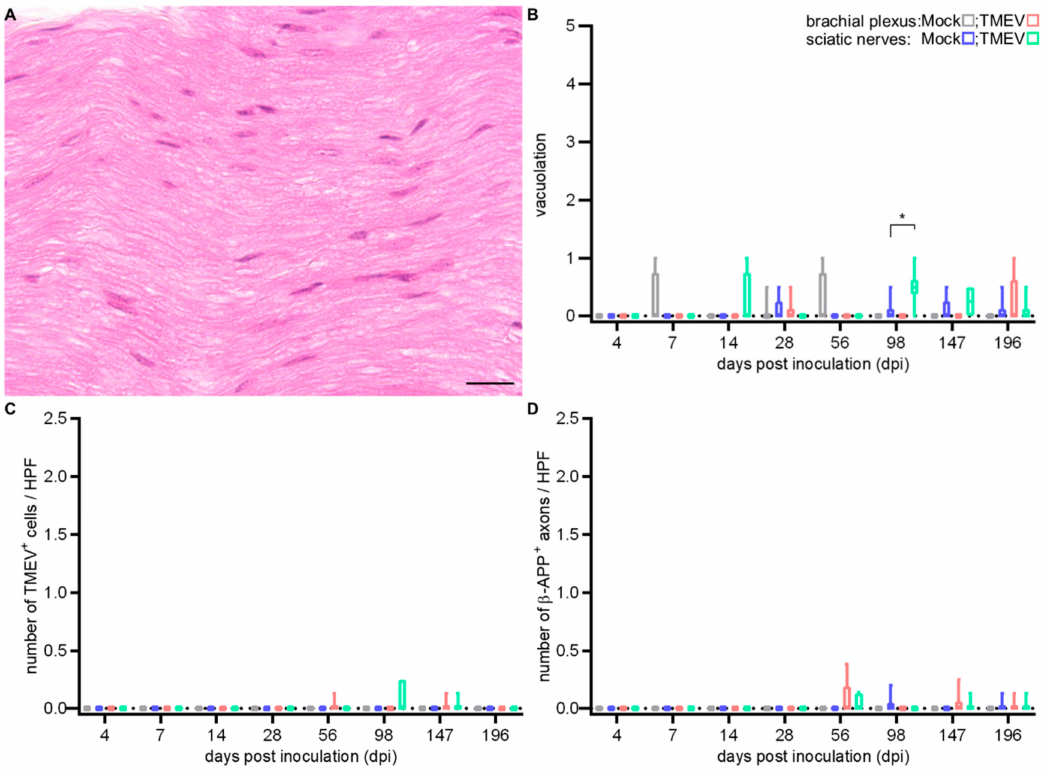
Figure 9. Light microscopical examination following i.c. TMEV infection revealed no lesions in sciatic nerves at 56 dpi ( A ). A mild vacuolation of PN was observed at 98 dpi in sciatic nerves. ( B ), while virus protein ( C ) as well as axonal damage ( D ) were occasionally observed. Graphs display the weighted average of left and right brachial plexus or sciatic nerves, respectively. Box-and-whisker plots show median and quartiles. Significant di ff erences between the groups as detected by a Mann–Whitney U-test are indicated by asterisks (* p < 0.05). Bars represent 20 µ